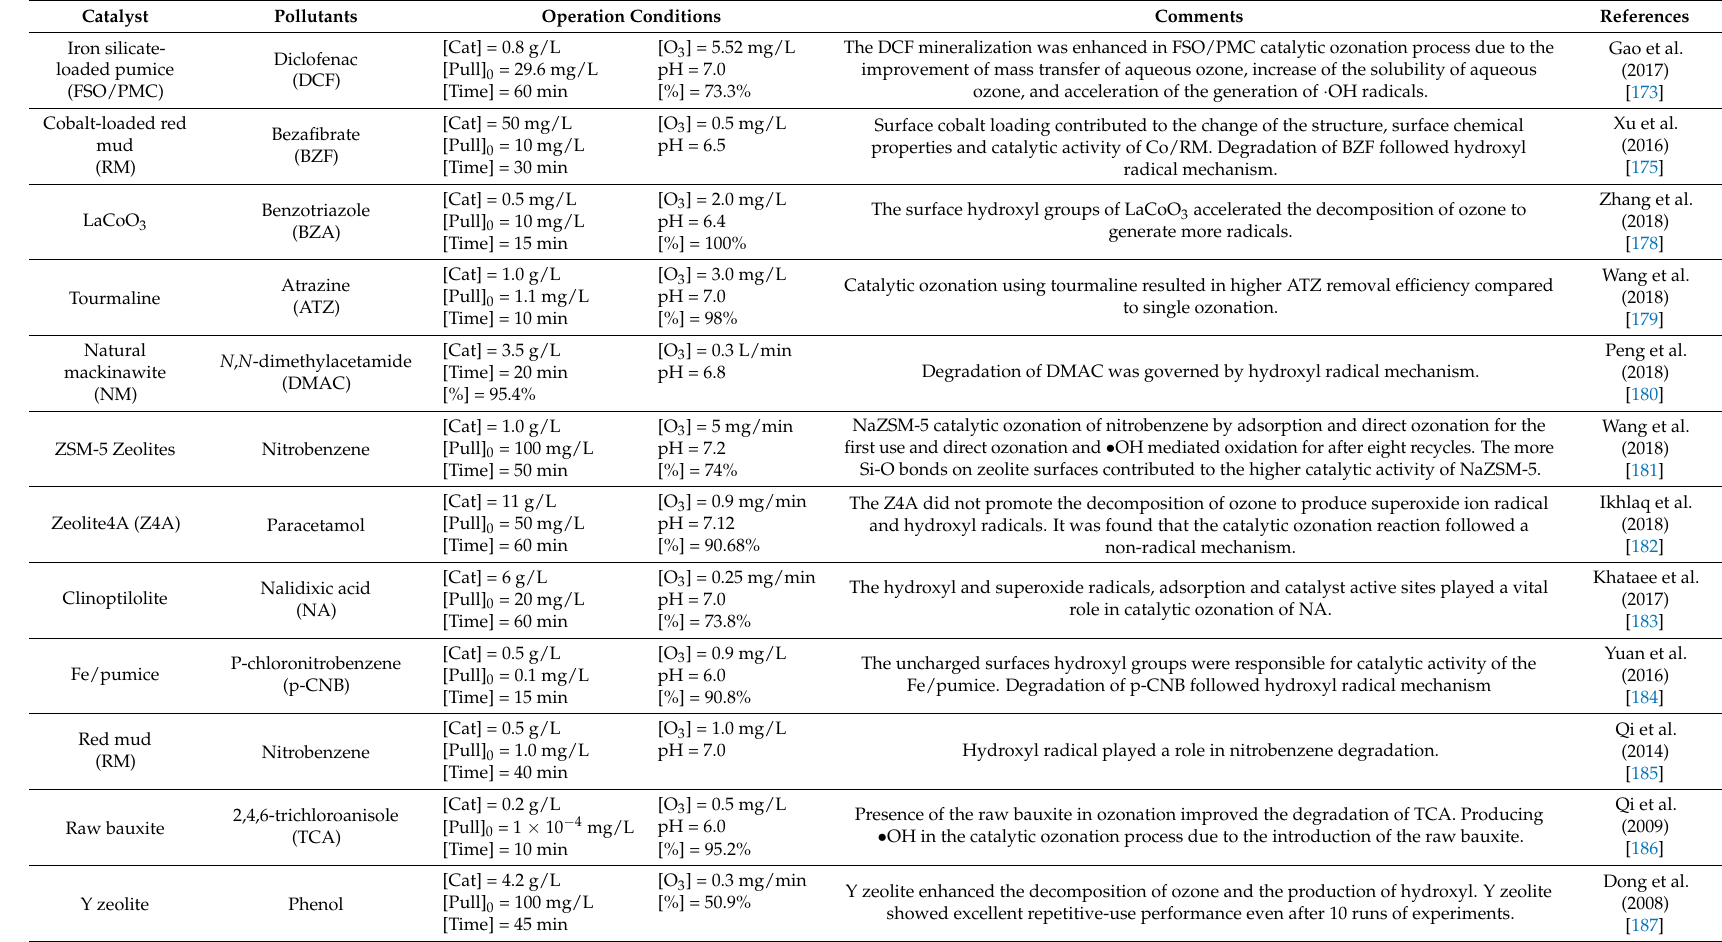
Table 11. Minerals modified with metals for catalytic ozonation